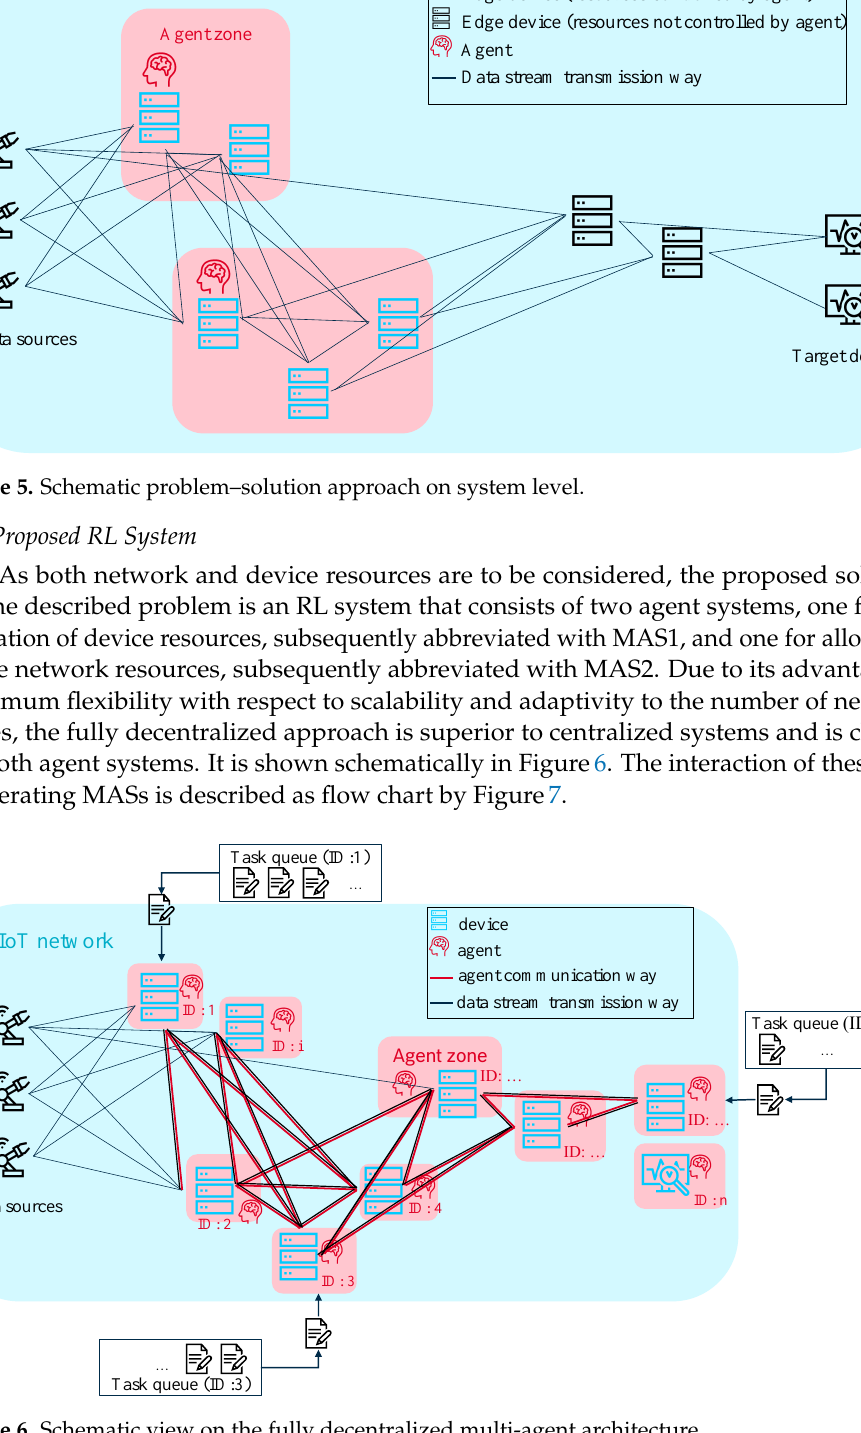
Figure 6. Schematic view on the fully decentralized multi-agent